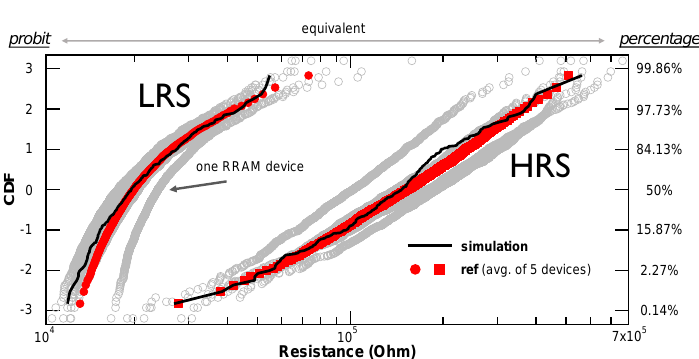
Figure 3: The resistance distributions of LRS and HRS over one thousand set/reset cycles of a RRAM, showing a good match between simulation and the referenced measurement data. The vertical axis shows in probit scale corresponding to the cumulative percentage of a standard Gaussian distribution as